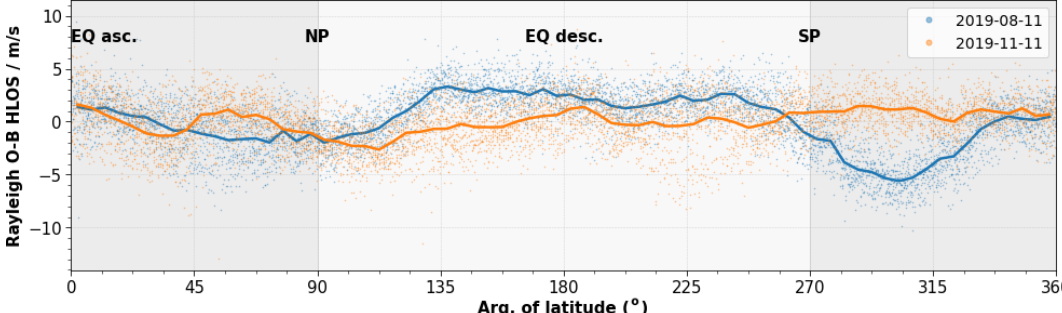
Figure 5. Rayleigh clear E(O − B) HLOS statistics as a function of the argument of latitude on 11 August (blue) and 11 November (orange) 2019. The argument of latitude describes the position of the satellite along its orbit in the ascending (asc., dark grey) and descending (desc., light grey) orbit phase (EQ: Equator; NP: North Pole; SP: South Pole). The blue and orange dots indicate the E(O − B) values which correspond to averaged O − B values over all altitudes at observation level (introduced in Sect. 2.4). The blue and the orange lines show the E(O − B) values as binned averages using a bin size of 5 ◦ for the argument of